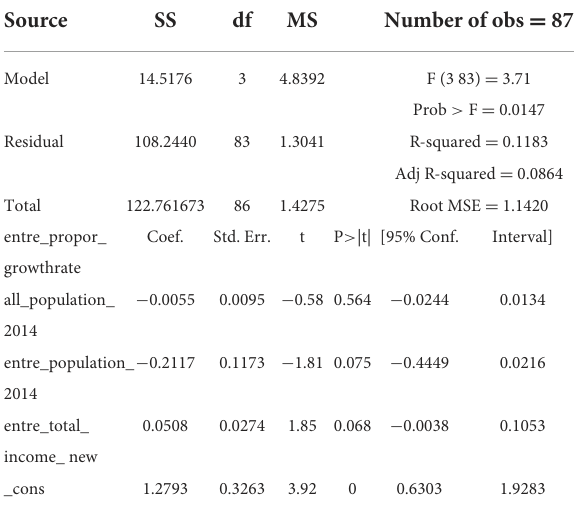
TABLE 7 The analysis of the correlation between the growth rate of the proportion of entrepreneurial population and the difference between entrepreneurial income and community per capita income in non-entrepreneurial communities.